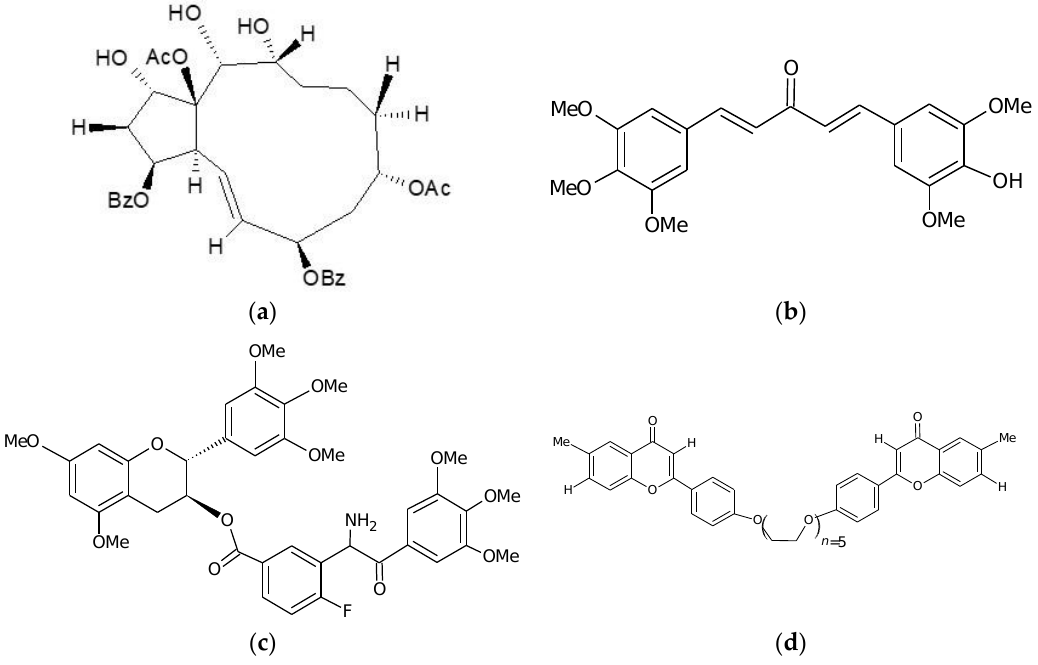
Figure 3. Other Potent MDR reversal agents. ( a ) Compound 26. (1S,2S,3S,4S,7R,9R,13R,14R,15S)-9,15-Fiacetoxy-3,7-dibenzoyloxy-1,13,14-trihydroxyjatropha-5E-ene [55]. ( b ) GO-Y078. (1E,4E)-1-(4-hydroxy-3,5-dimethoxyphenyl)-5-(3,4,5-trimethoxyphenyl)penta-1,4-dien-3-one [29]. ( c ) Compound 51. (2R,3S)-5,7-Dimethoxy-2-(3,4,5-trimethoxyphenyl)chroman-3-yl. 3-(3,4,5-trimethoxybenzamido)-4-fluorobenzoate [56]. ( d ) Compound 4e. 1,16-Bis[40-((6-methyl)-4H-chromen-4-on-2-yl)phenyl]-1,4,7,10, 13,16-hexaoxahexadecane [56].